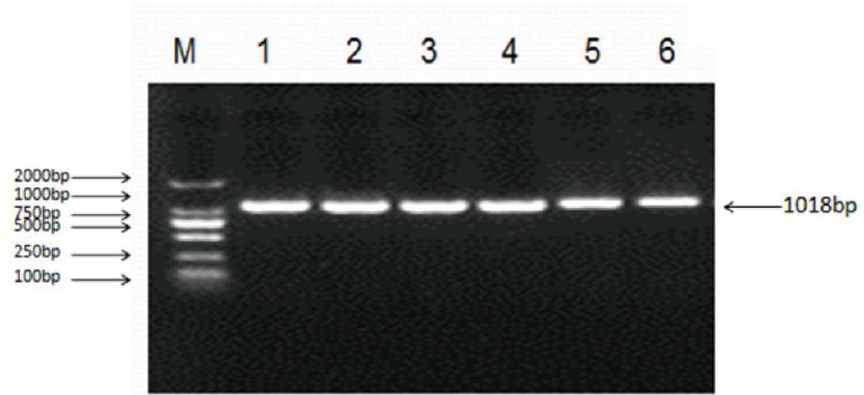
Figure 5. Polymerase chain reaction (PCR) amplification of the ovine LH β gene. 1~6 Lane: 1018 bp fragment of ovine LH β gene; M: DNA Marker (DL2000).